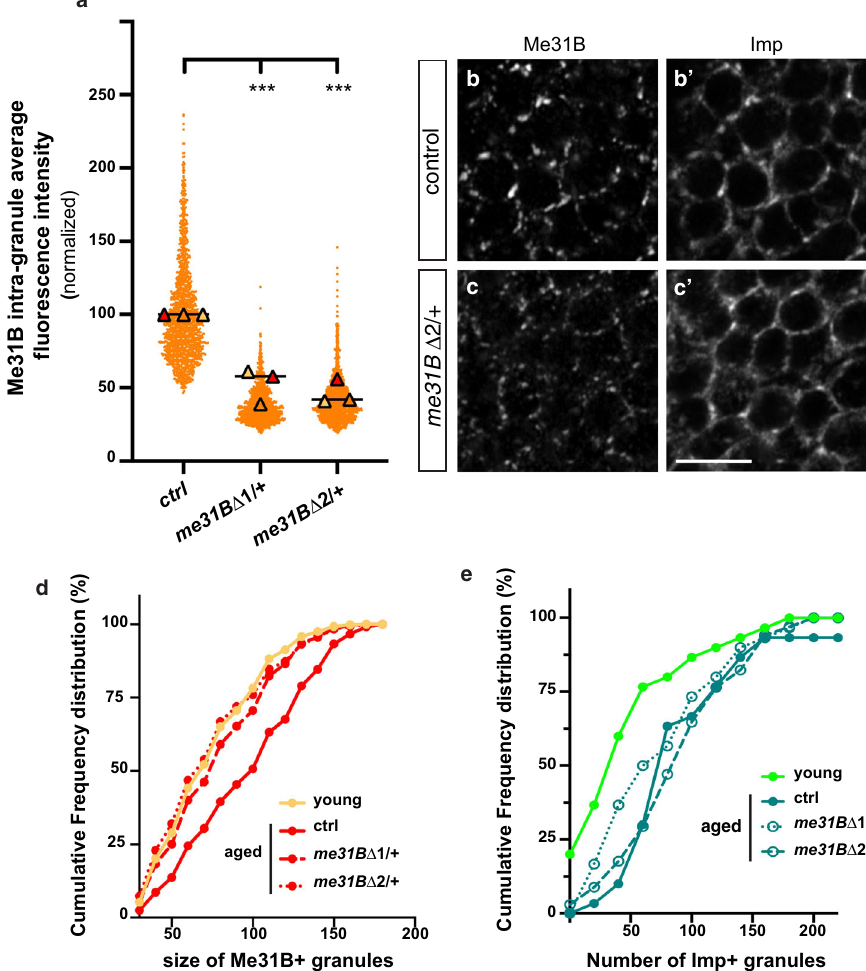
Fig. 5 Reducing Me31B levels decreases Me31B condensation. a Intra-granule concentration of Me31B-GFP in granules of 37 – 38 day-old me31B Δ 1 / + and me31B Δ 2 / + MB γ neurons. Three replicates were performed and the mean value of each replicate is indicated as a symbol (triangle). Values were normalized to the control condition. The distribution of individual granule values is shown for one replicate only. *** P < 0.001 (one-way ANOVA with Dunn ’ s multiple comparison tests). b , c Cell bodies of control ( b , b ’ ) and me31B Δ 2/ + ( c , c ’ ) MB γ neurons from 37 – 38 day-old brains stained with anti- Me31B ( b , c ) and anti-Imp ( b ’ , c ’ ). Scale bar: 5 μ m. d Sizes of Me31B-containing granules in MB γ neurons of 1 – 2 day- (light orange; young) and 37 – 38 day- (red; aged) old brains. Values were normalized to aged controls. Cumulative frequency distributions are plotted for one replicate, but three replicates were performed in total (see Supplementary Fig. 4d). *** P < 0.001 (one-way ANOVA test). e Numbers of Imp + granules (per surface area) in MB γ neurons of 1 – 2 day- (light green; young) and 37 – 38 day- (green; aged) old brains. Values were normalized to aged controls. Cumulative frequency distributions are plotted for one replicate, but three replicates were performed in total (see Supplementary Fig. 4f). *** P < 0.001 (one-way ANOVA test). Source data are provided as a Source Data fi